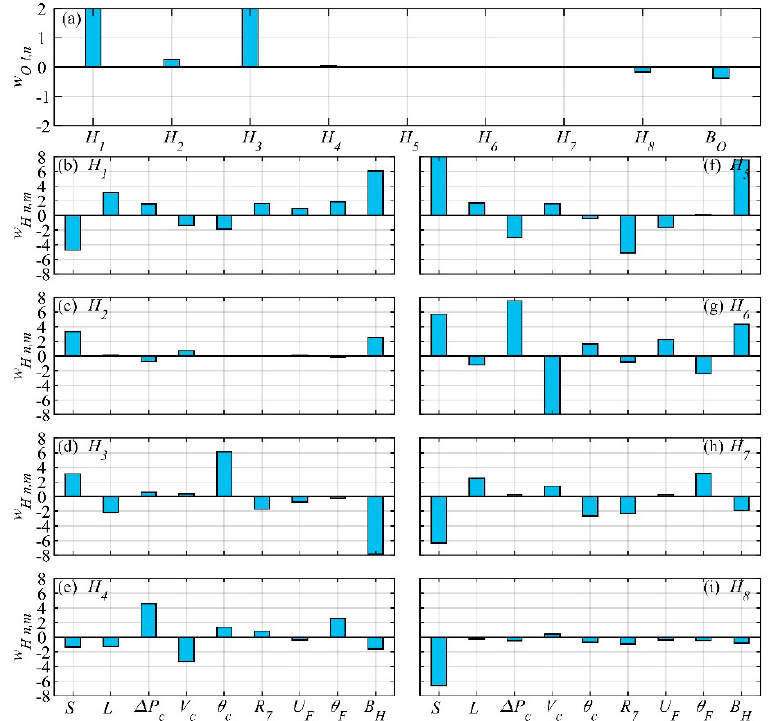
Figure 5. ( a ) Weights and bias of output-layer neuron ( w Ol,n and B O ); ( b – i ) Weights and bias of each